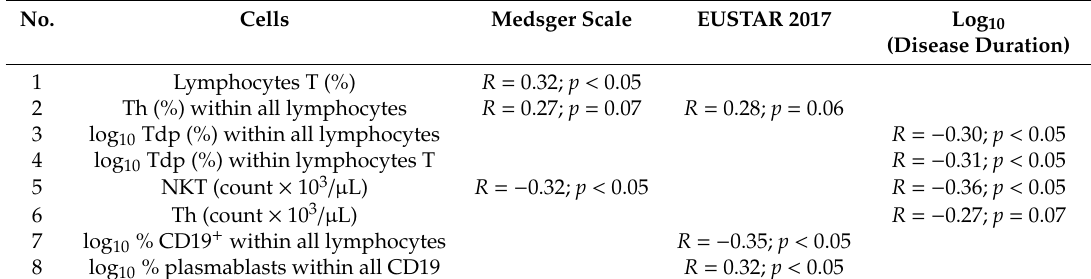
Table 4. Changes in immunocompetent cells in patients with systemic sclerosis in correlation to the disease duration, activity, and